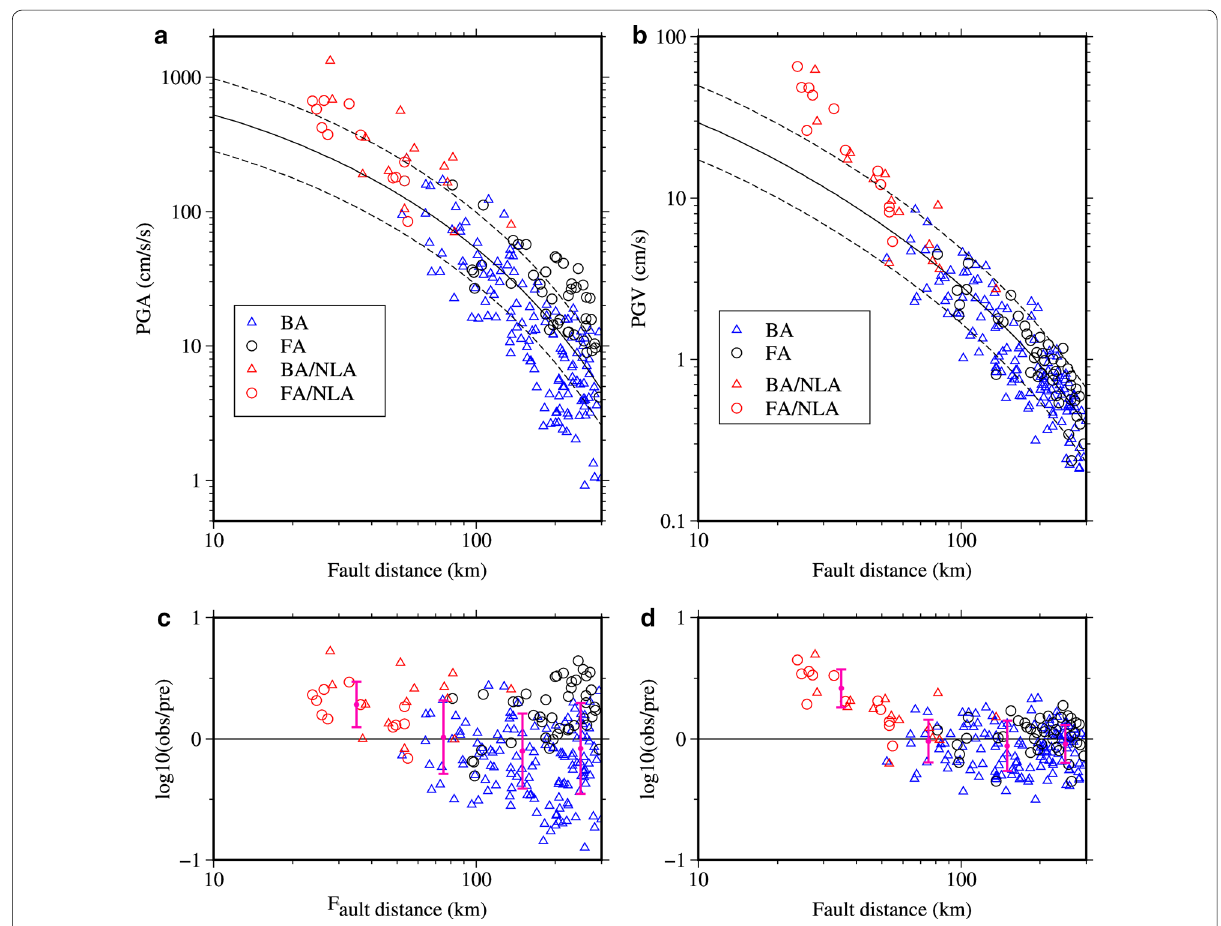
Fig. 2 a , b Plots of observed PGAs (larger of two horizontal components) and PGVs (larger of two horizontal components) after adjustment for site amplification, respectively. Only a subset of data shown in Fig. 1a were plotted where the values of Vs30 were known or estimated. The solid lines represent median prediction curves using equations in Si and Midorikawa (1999, 2000) for Mw dashed lines denote plus–minus one standard deviation. In the legends, BA, FA, and NLA are the abbreviations for back-arc, fore-arc, and nonlinear site response analyzed sites. c , d Plots of residuals for the PGAs and PGVs plotted in a , b , respectively. Mean residuals with a plus–minus one standard deviation are shown by vertical bars for four different distance ranges 20–50 km, 50–100 km, 100–200 km, and 200–300